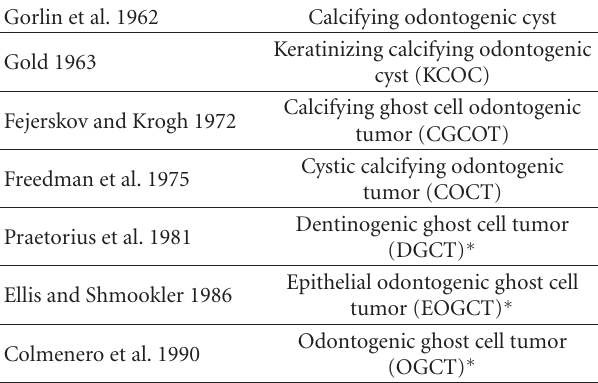
Table 1: Terminology of the so-called calcifying odontogenic cyst